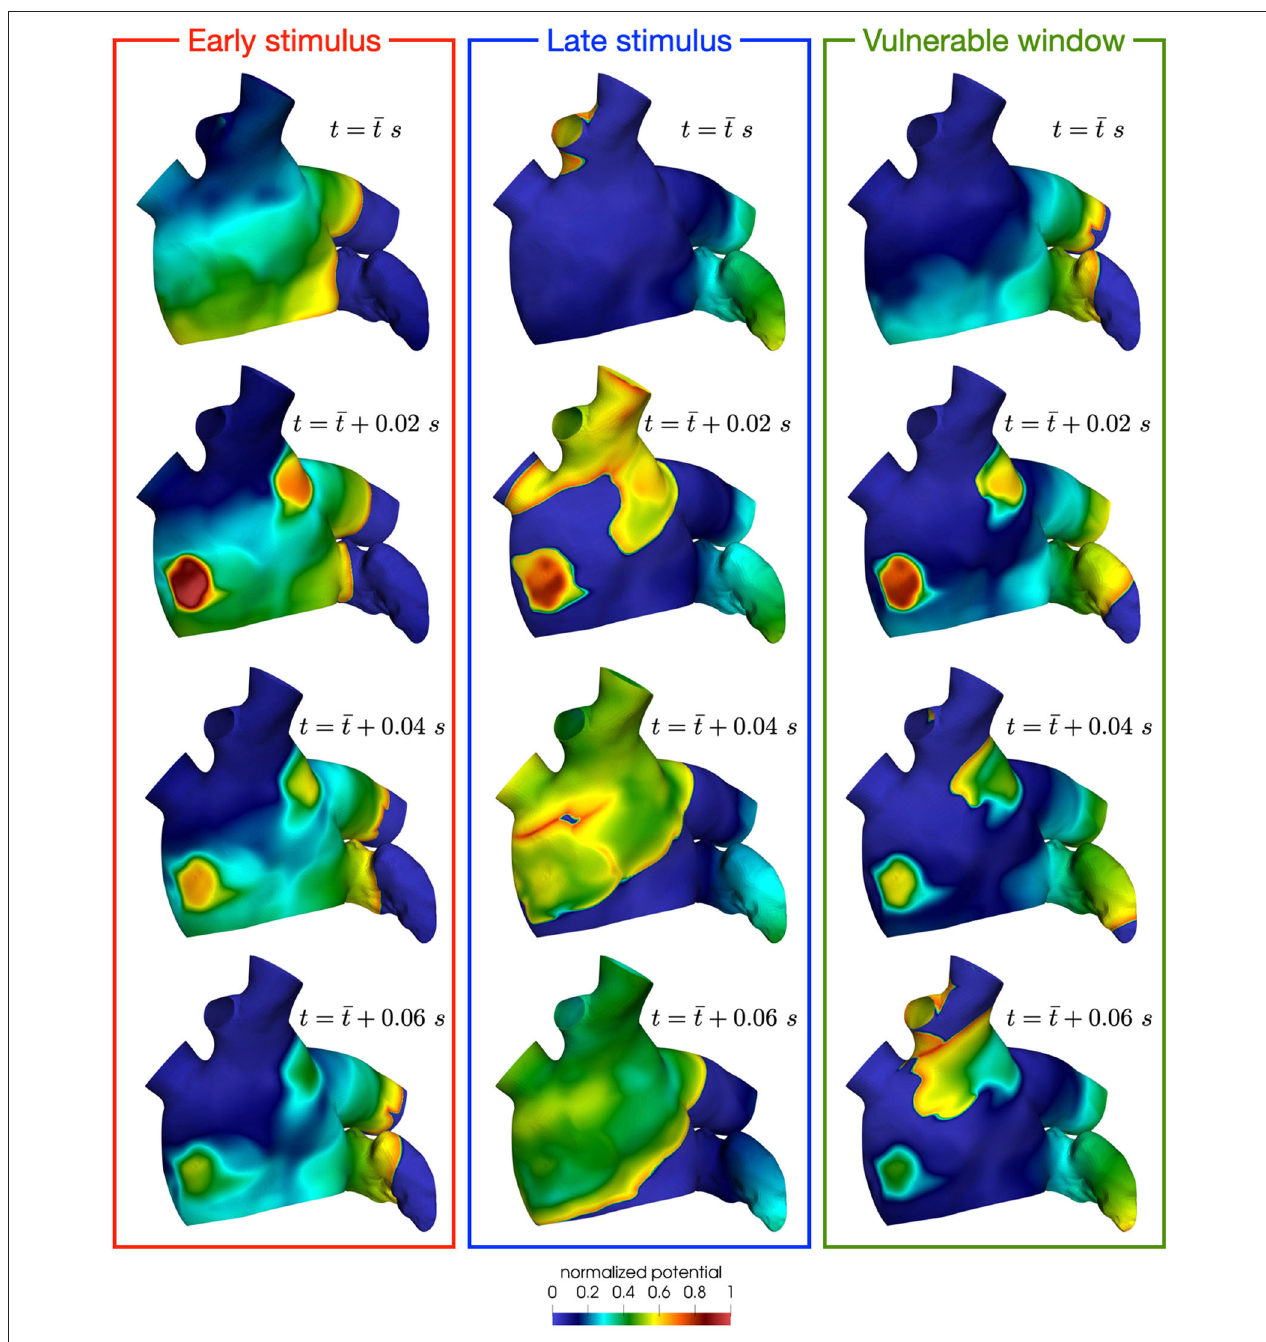
FIGURE 12 | Effect of a stimulus delivered before (left) , after (center) or in the vulnerable window (right) . Only in the latter case, the instability creates rotors that might form reentrant circuits.